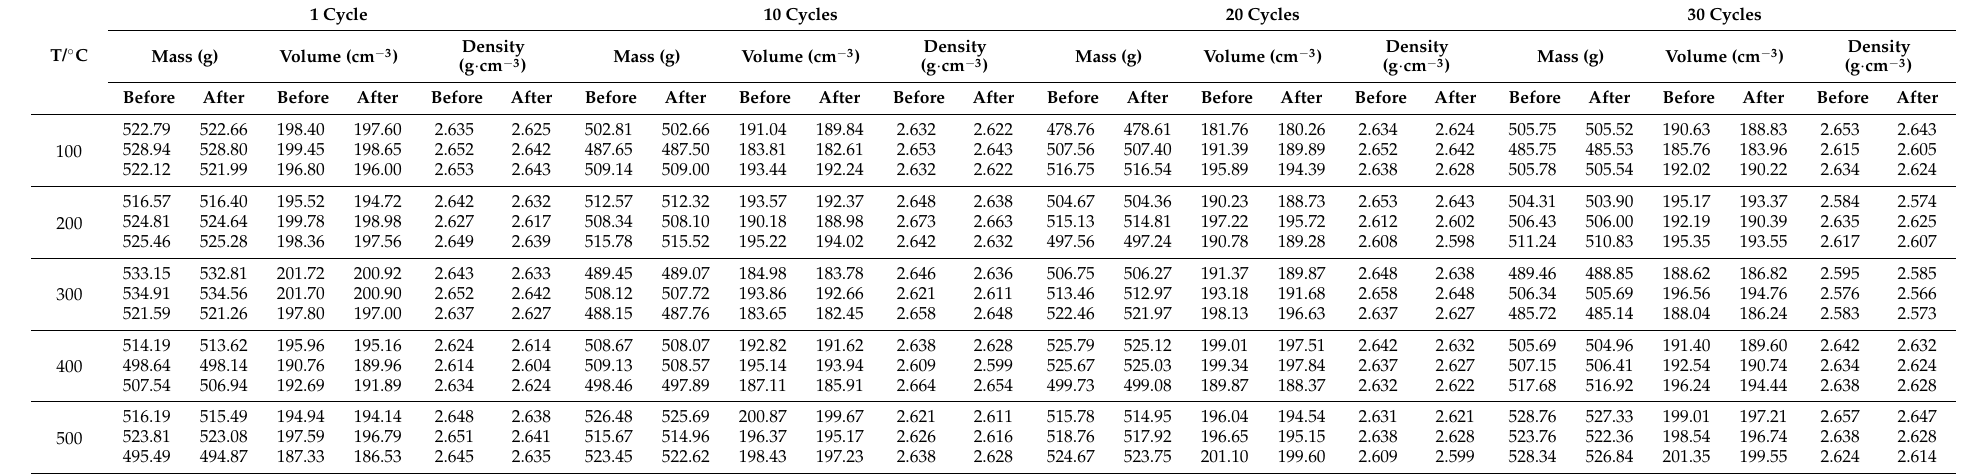
Table 1. Mass, volume, and bulk density of granites induced by thermal cycling